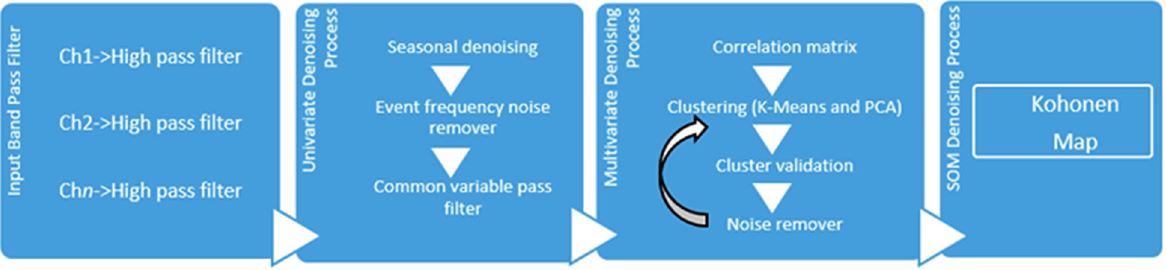
Figure 13. AE noise filtering procedure (Reproduced and modified from